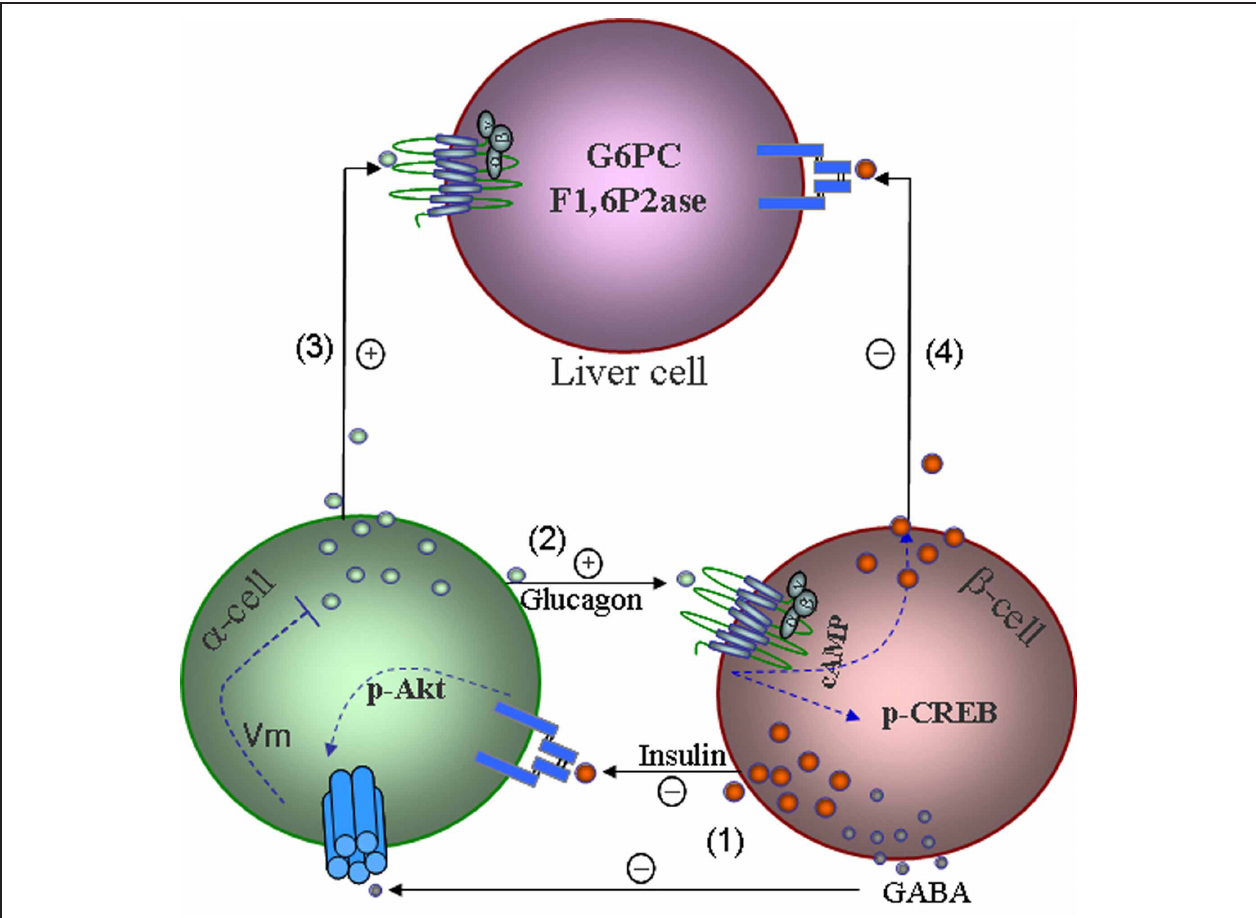
FIGURE 1 | A model shows mechanisms underlying intra-islet hormonal regulation and their impact on liver glucose production. (1) Insulin, incorporation with GABA produced from β -cells suppresses glucagon secretion via membrane hyperpolarization. (2) Glucagon stimulates glucose-competent β -cell secretion and increases α -cell gene transcription via activation of CREB. (3) Glucagon increases its action in the liver on glucose